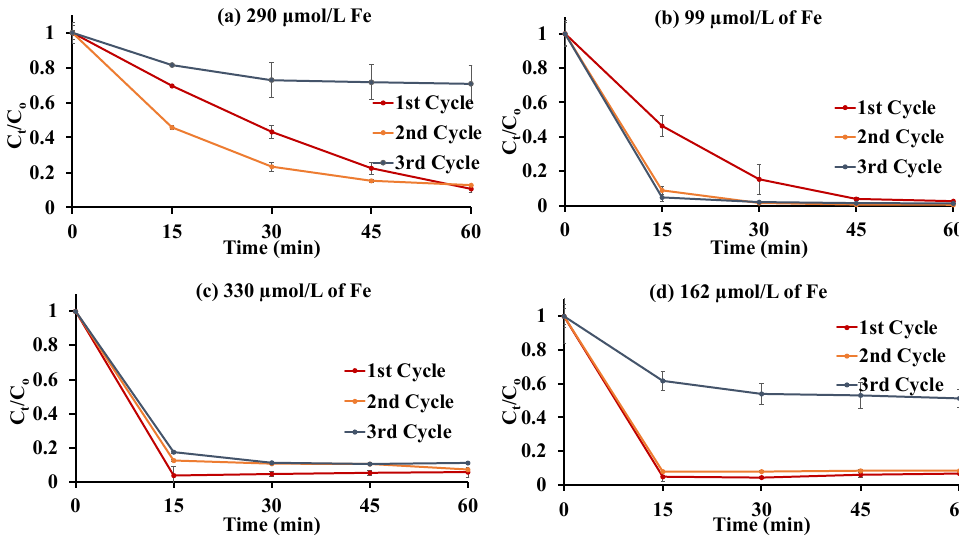
Figure 6. Degradation of MB in successive addition cycles for ( a ) 1000 mg St–Fe, ( b ) 300 mg St–Fe, ( c ) 300 mg Fe–St, and ( d ) 100 mg Fe–St with 360 μ mol/L H 2 O 2 , 350 nm UV irradiation at pH 4, and 4 mg/L MB in each cycle.